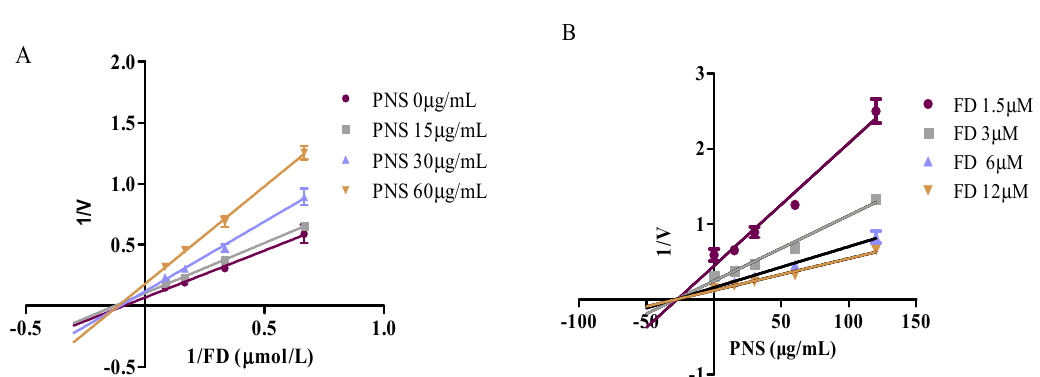
Figure 3. Various concentrations of PNS were used to measure the half inhibition concentration toward hCE2. Each point represents the mean of three independent experiments.